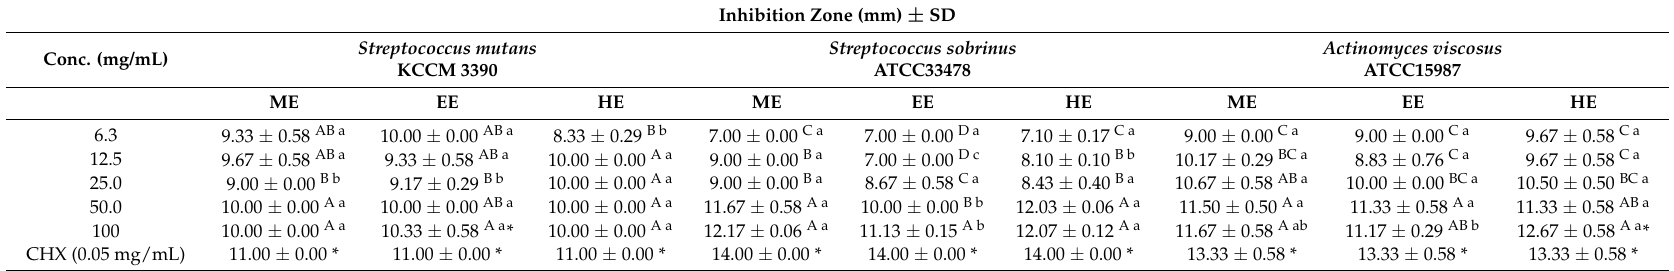
Table 2. Results of disc diffusion assay (DDA) for P. cubeba L. extracts against oral